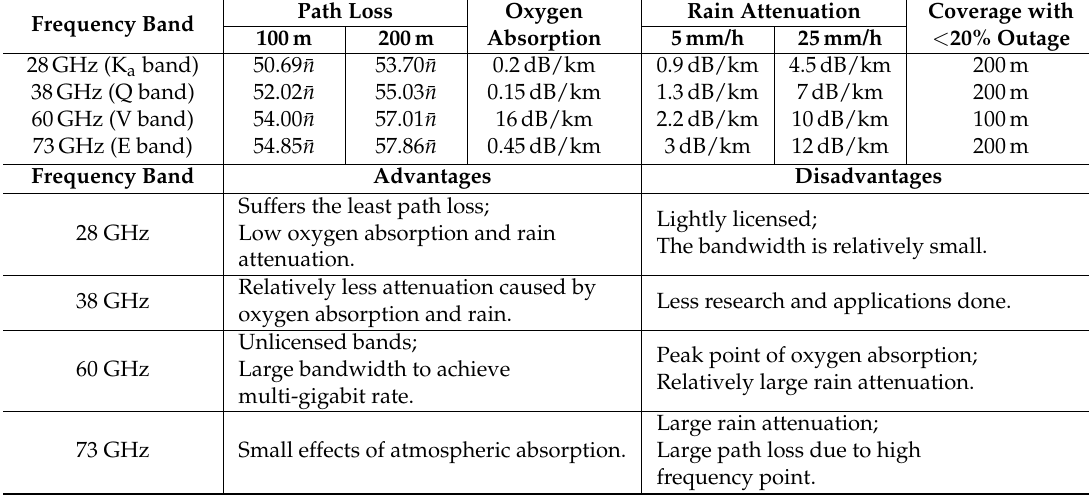
Table 1. A brief summary of mm-wave communication in several frequency